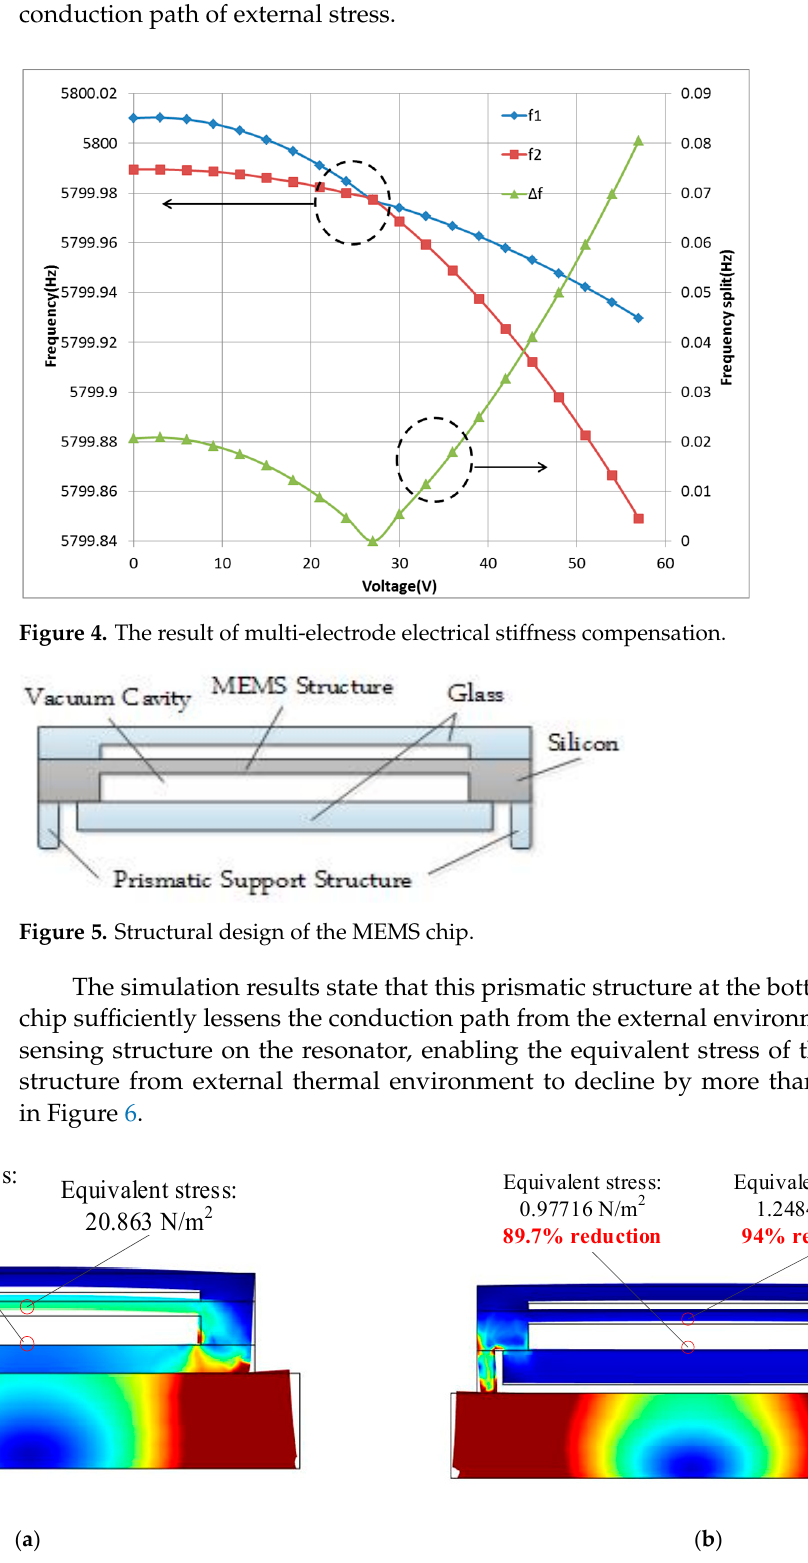
Figure 4. The result of multi-electrode electrical stiffness compensation.